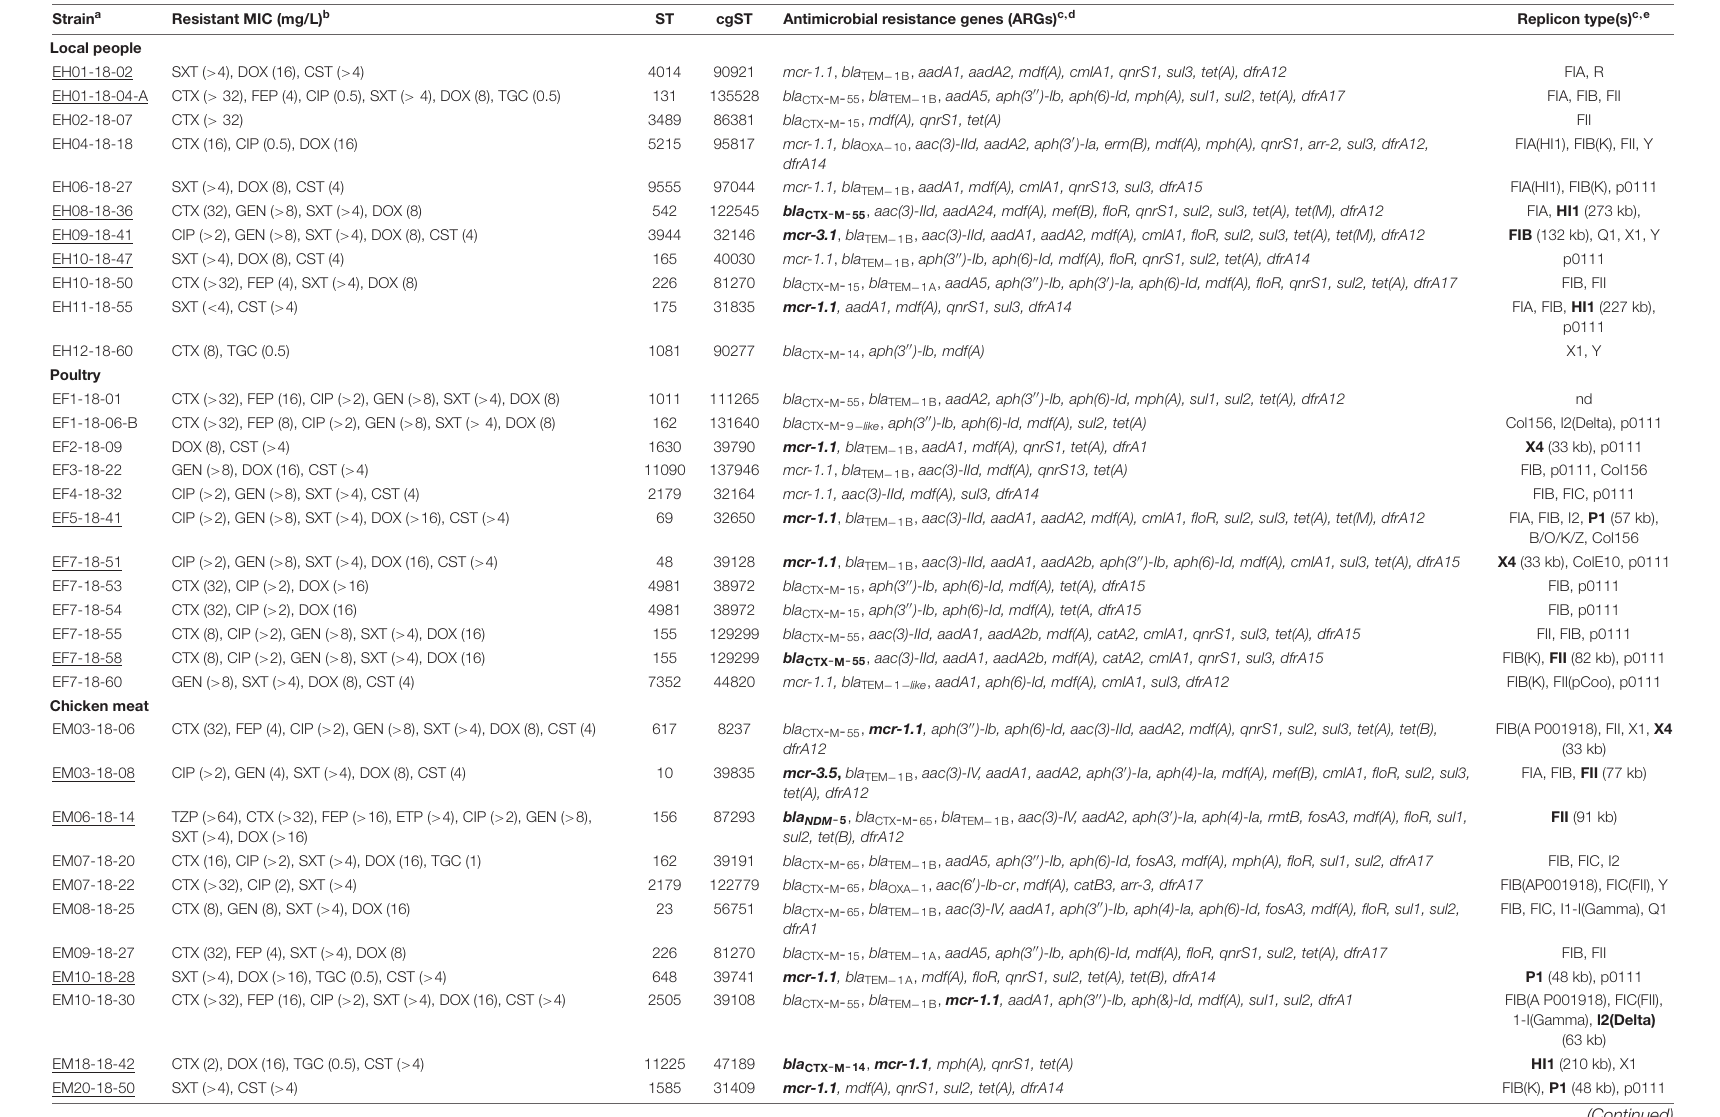
TABLE 2 | Phenotypic and molecular features of the 49 E. coli that underwent WGS isolated from rectal swabs of local residents ( n = 11), chicken stool ( n = 12), chicken meat ( n = 14), and 9 travelers visiting Laos (pre-trip n = 2; post-trip n = 10). Strain a Resistant MIC (mg/L) b ST cgST Antimicrobial resistance genes (ARGs) c , d Replicon type(s) c , e Local people